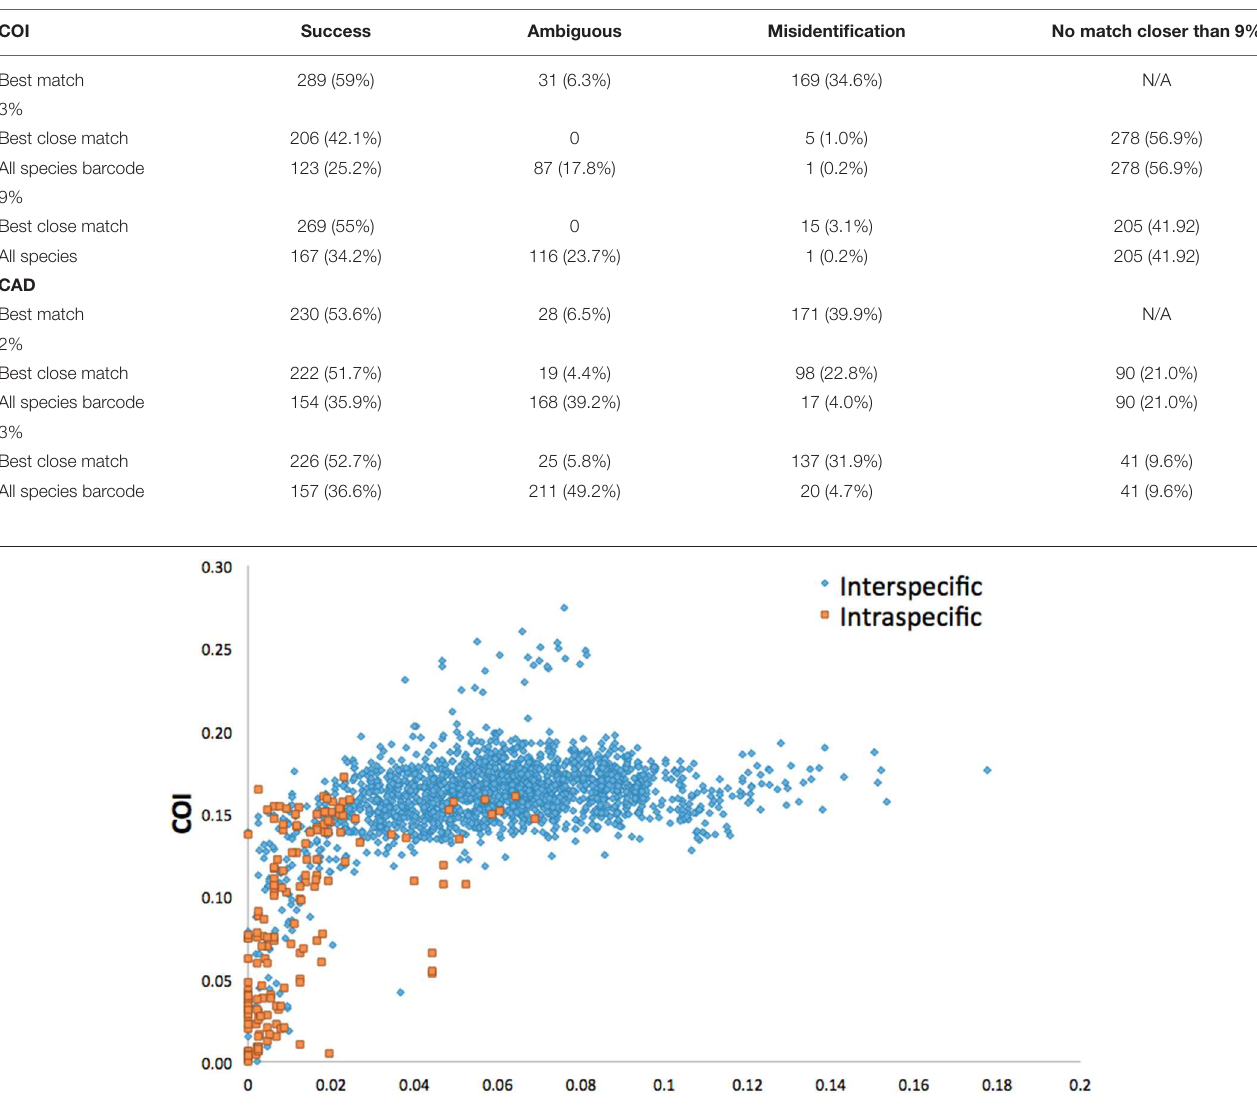
TABLE 2 | Identification success with various similarity thresholds using DNA match method.